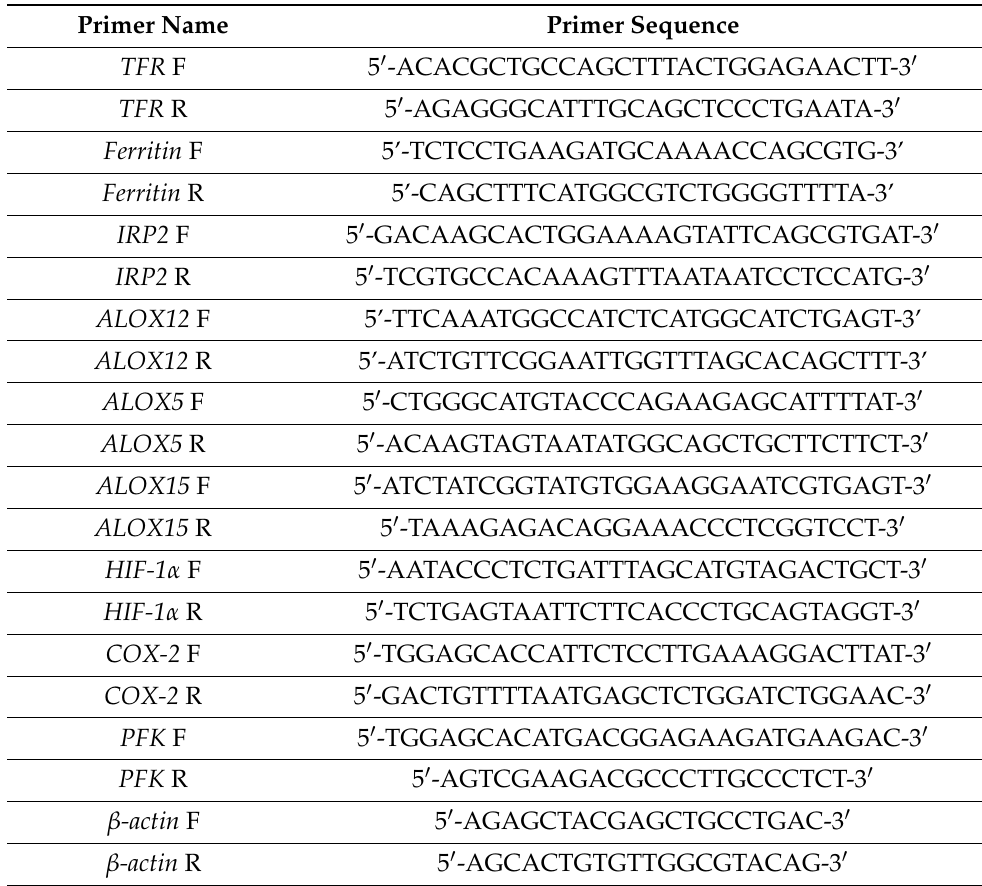
Table 1. Primer sequence used in this